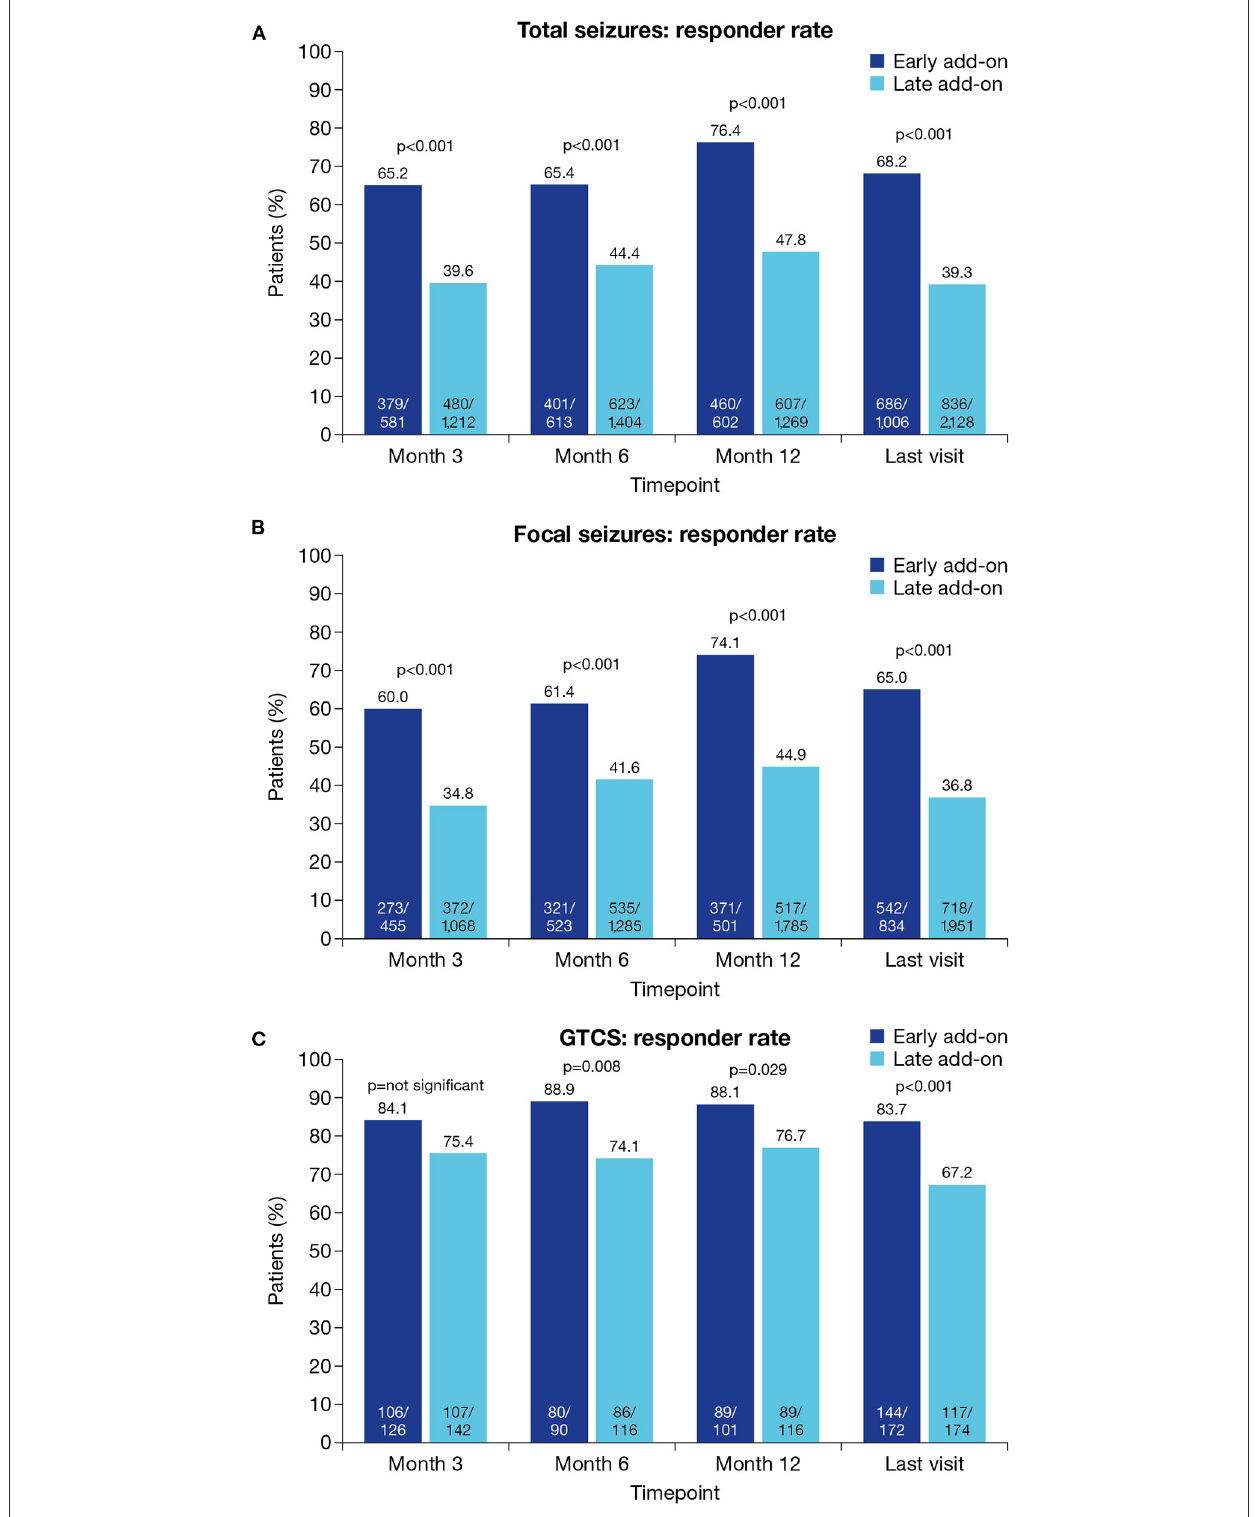
FIGURE3 Responder rates at Month 3, Month 6, Month 12 and the last visit in the early and late add-on subgroups for (A ) total seizures, (B ) focal seizures and (C) GTCS (effectiveness population). Response was defined as ≥ 50% seizure frequency reduction from baseline. GTCS, generalized tonic-clonic